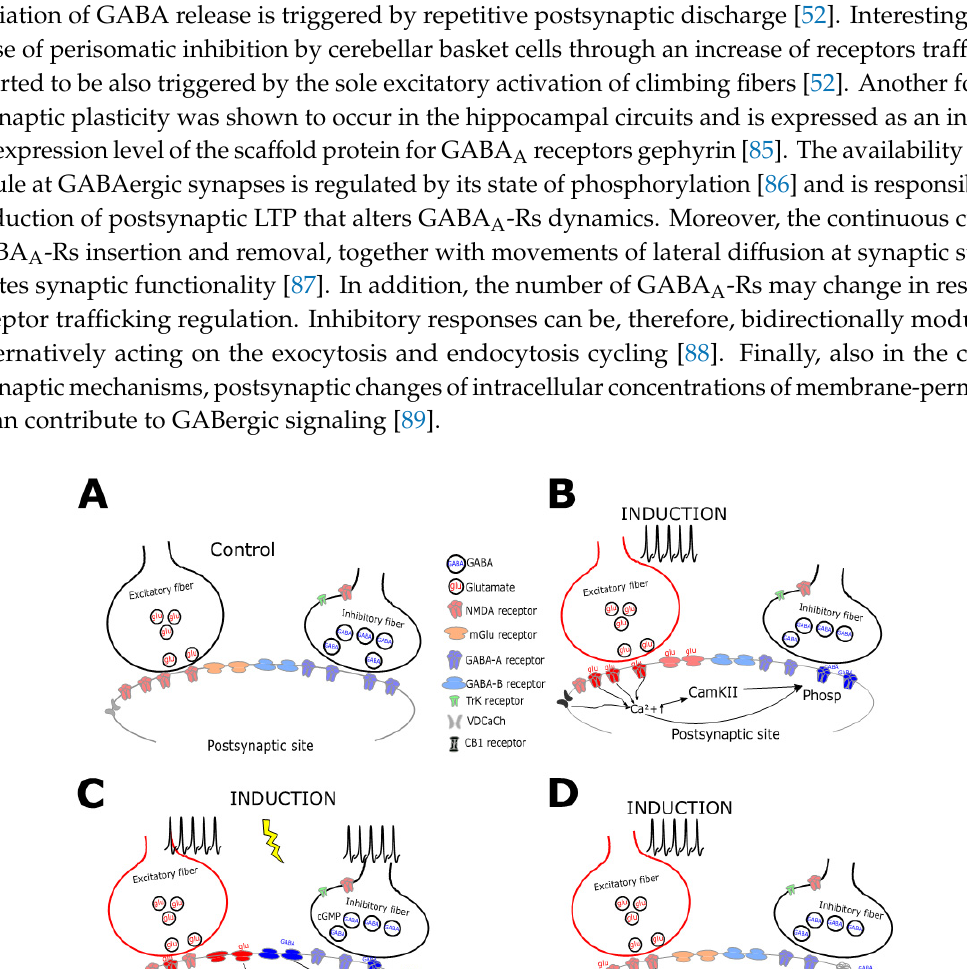
through NMDA-Rs or VDCaChs opening. Calcium increase can directly act on proteins phosphorylation (phosp) or can mediate CamKII activation leading to phosphorylation as well. Postsynaptic GABA-A